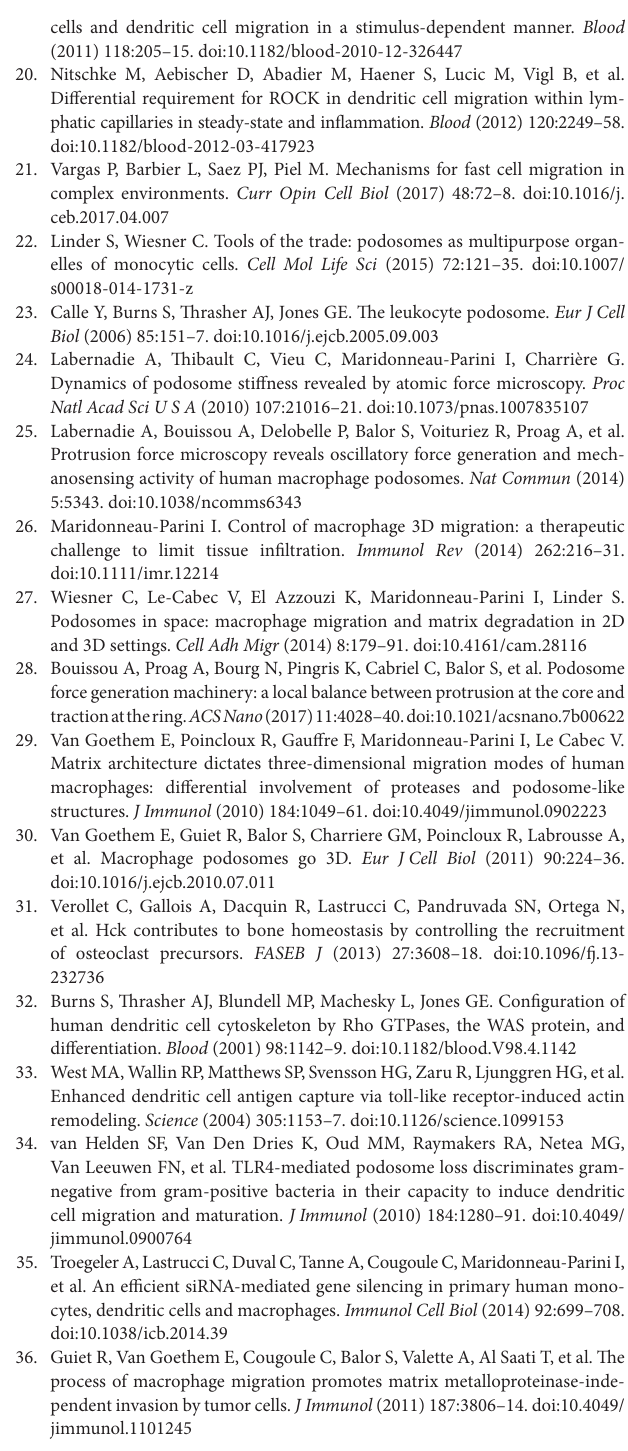
z-series of images were acquired after 24 h of migration at the surface of the matrices and at several depth (until 420 μm, 30 μm intervals) into the